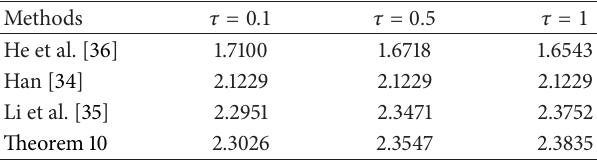
Table 1: Maximum upper bound of 𝑑 with different neutral delay 𝜏